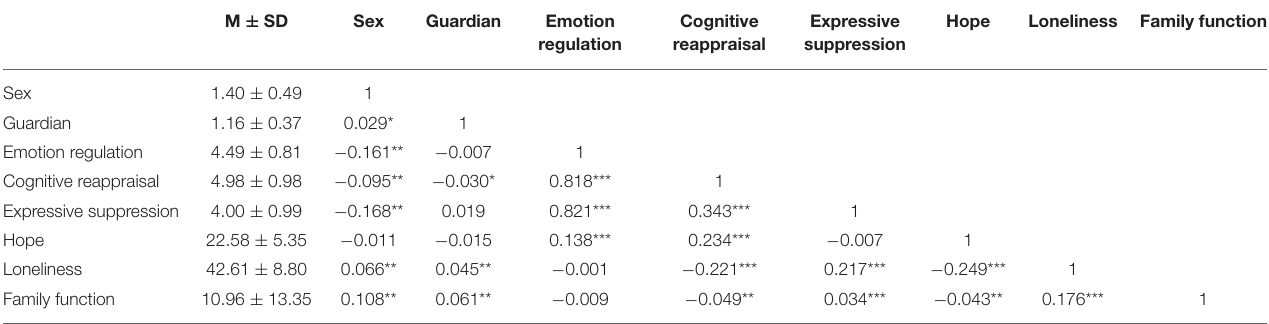
TABLE 2 | Means, standard deviations, and correlations among the study variables. M ± SD Sex Guardian Emotion